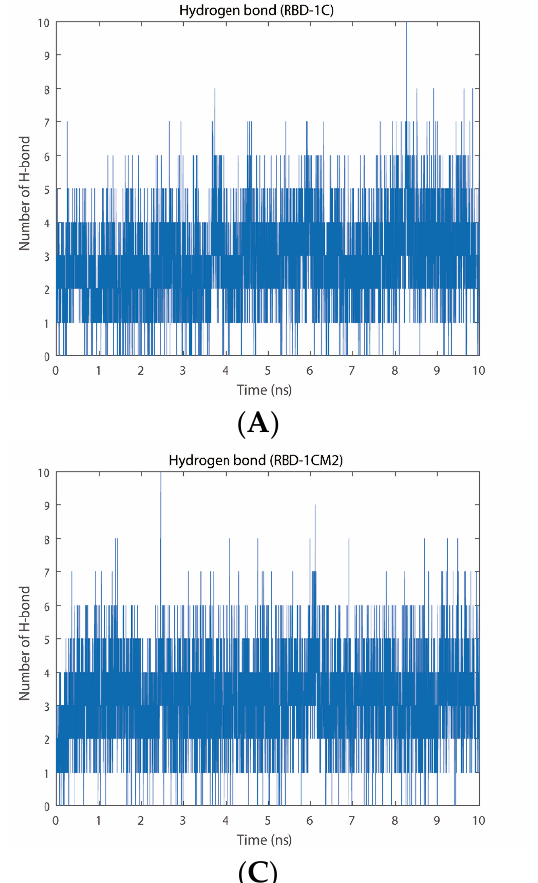
Figure 5. Number of hydrogen bonds of ( A ) the S protein/RBD-1C complex, ( B ) S protein/RBD-1CM1 complex, and ( C ) S protein/RBD-1CM2 complex during the 10 ns MD simulation.